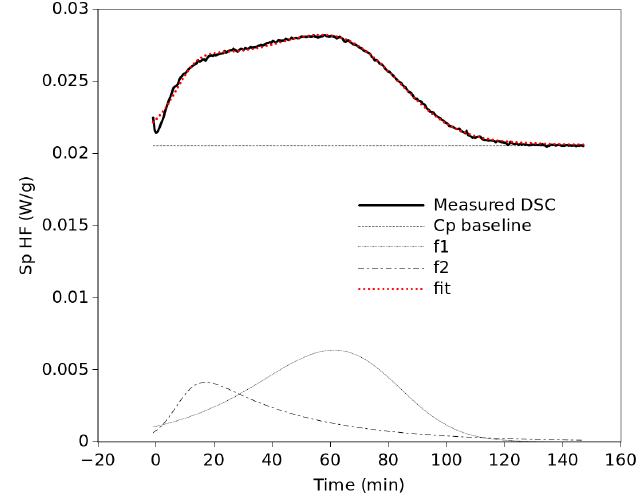
Figure 6. Fitting of a DSC curve by two TDGL functions. Table 2. Parameter values, according to Equation (3), obtained for the rate parameter from the fittings of all curves.